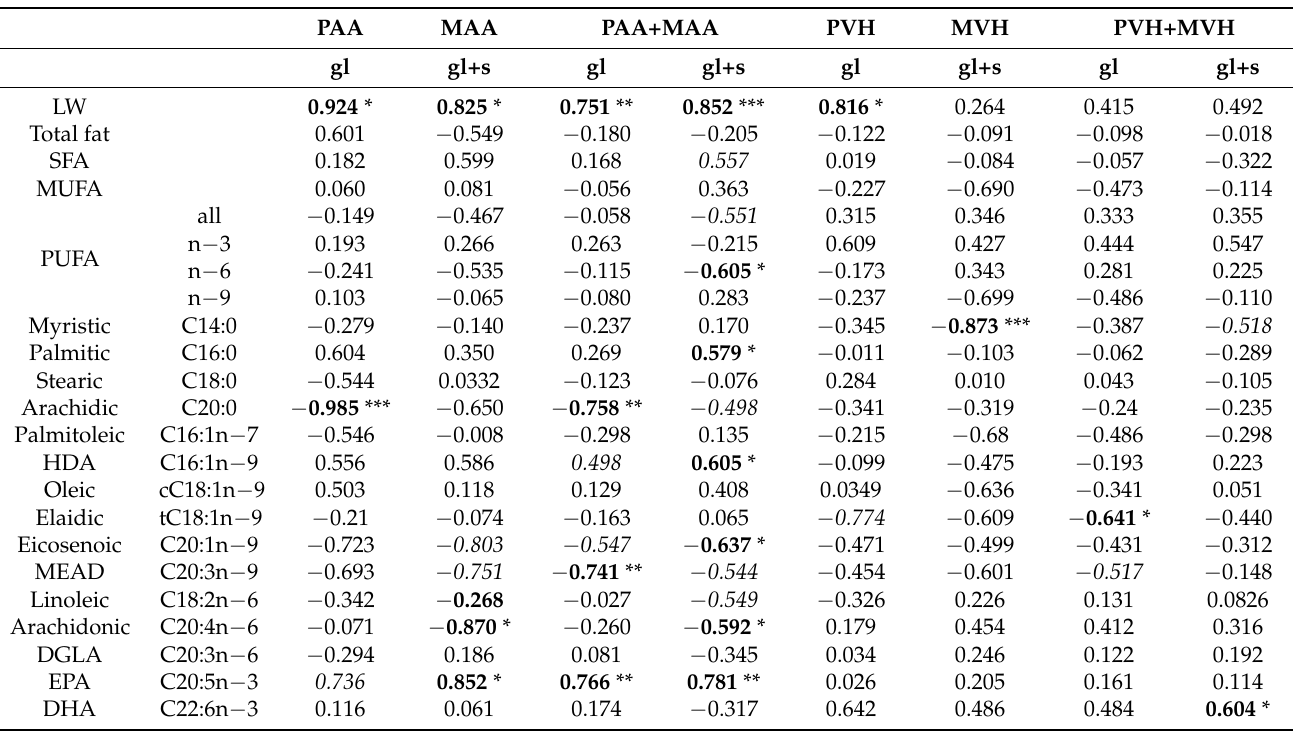
Table 2. Correlations between FA dose, total fat content, and % FA by degree of saturation and individual